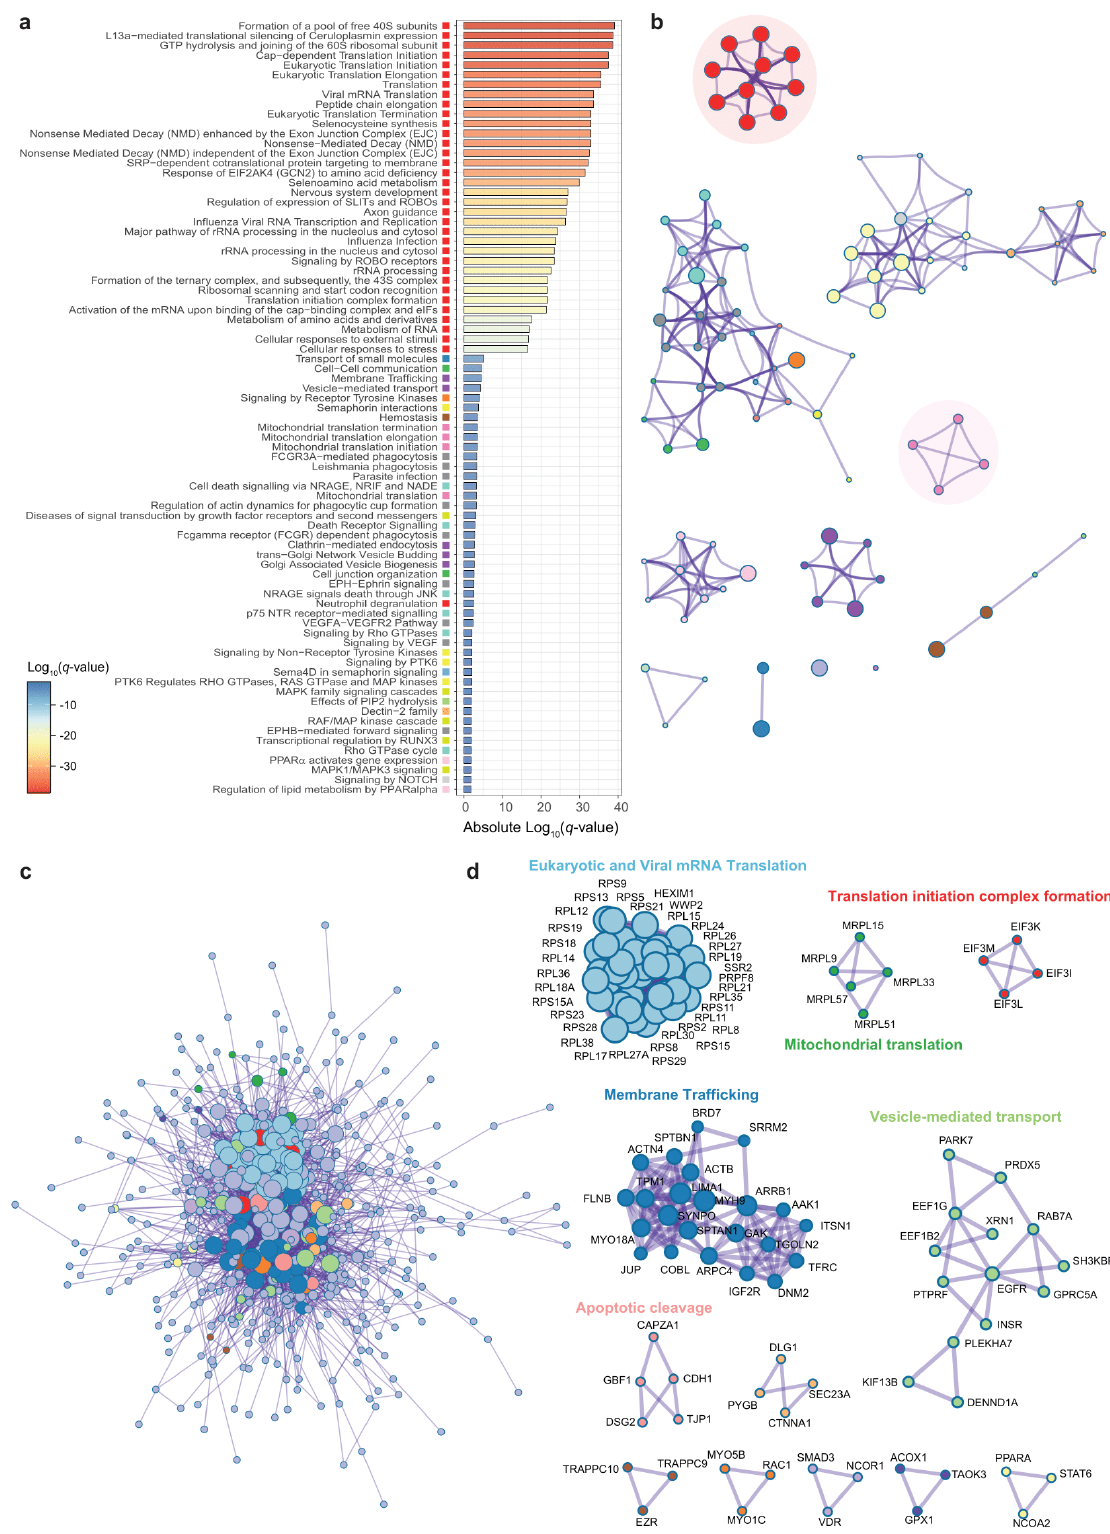
Figure 3. Pathway enrichment and interactome analysis of gene transcripts significantly associated with DPP9 in the colon. ( a ) Bar chart of 80 first enriched Reactome gene sets sorted by Log 10 ( q -value). Each gene set have been associated with a cluster represented by different colors. ( b ) Enrichment network. Each node represents a pathway colored by cluster ID. Colors correspond to the clusters showed in panel ( a ). Node size is proportional to the number of input genes falling into